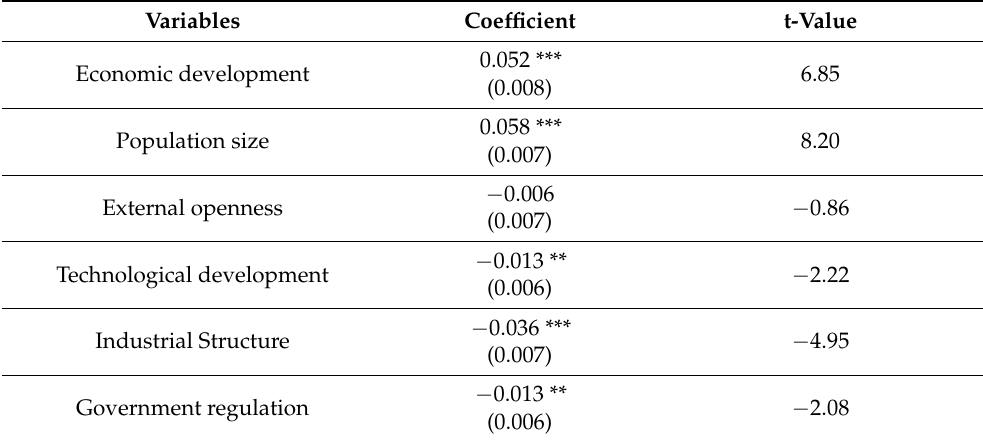
Table 6. Regression results according to Tobit